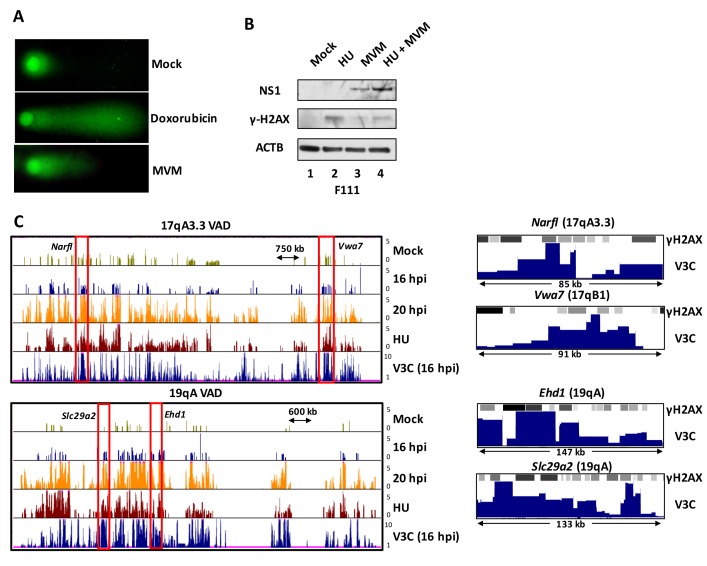
MVM DNA damage interactions.(A) Alkaline comet assays were performed in uninfected, doxorubicin treated (200 nM) or MVM infected murine A9 cells for 24 hr, and DNA fragmentation was visualized using immunofluorescence microscopy. (B) Immunoblot analysis of MVM infection in rodent F-111 cells pulsed with (or without) 2 mM HU for 4 hr prior to infection with MVM at an MOI of 10 for 20 hr. Cells were harvested as described and analyzed for MVM replication via assaying NS1 levels and γ-H2AX in the nuclear lysates. Beta-Actin levels were used as loading control for the immunoblots. (C) (Left) UCSC genome browser screenshots of the VAD regions on chromosomes 17 (17qA3.3) and 19 (19qA) demarcated by red boxes in Figure 3A. (Right) Representative UCSC genome browser screenshots of the red boxes in the left panel of Figure 3—figure supplement 2C at Narfl, Vwa7, Ehd1 and Slc29a2 loci containing SICER-called ChIP-seq peaks for gamma-H2AX in HU treated A9 cells and MVM interaction sites mapped by V3C-seq at 16 hpi.